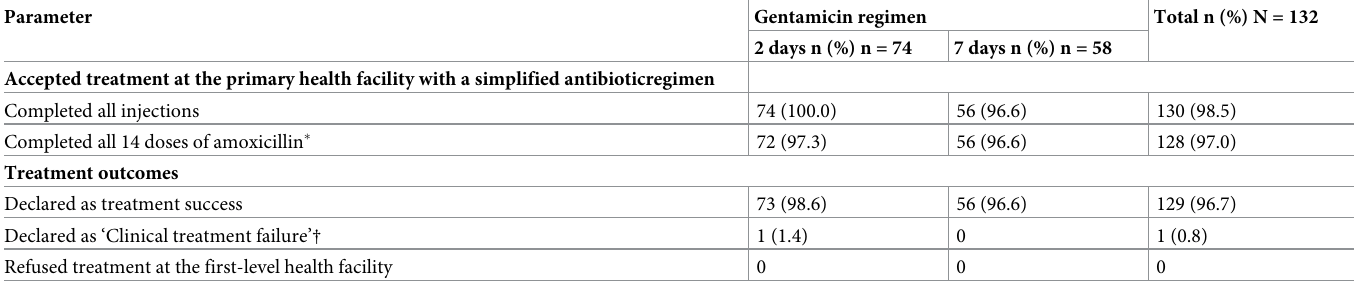
Table 3. Infants 0–59 days old with clinical severe infection treated at a health post or health centre with two-day or seven-day injectable gentamicin